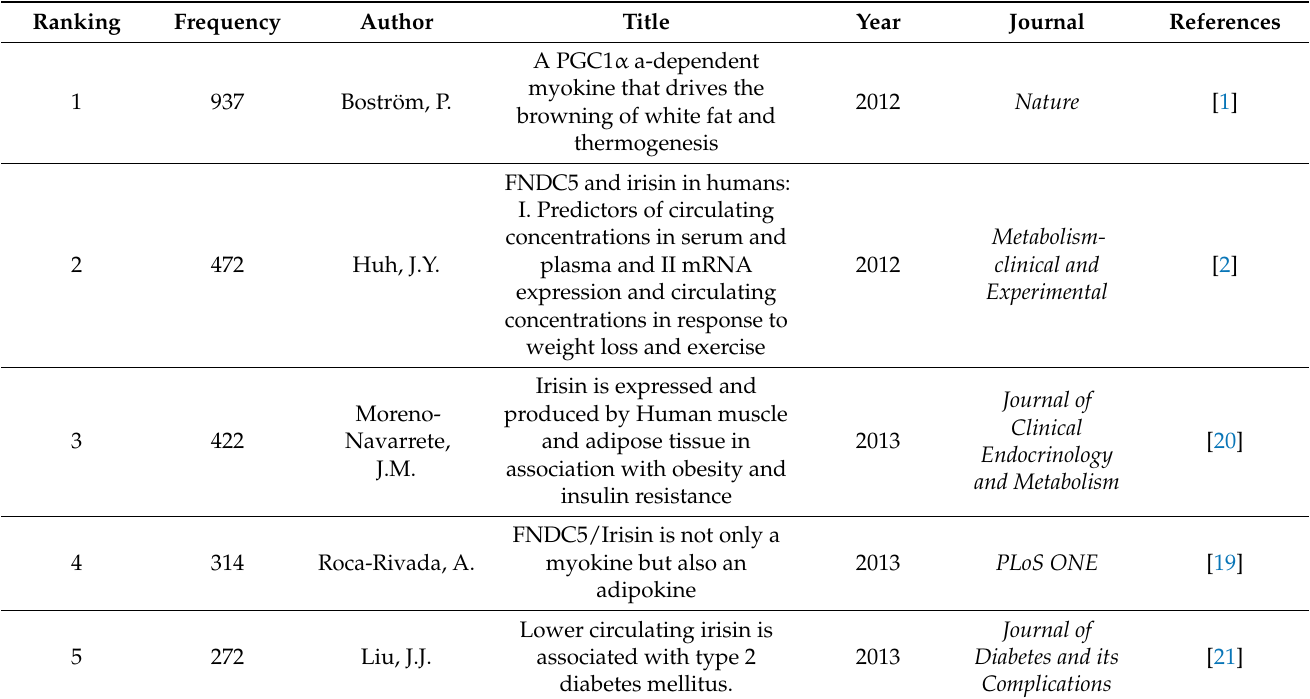
Figure 8. Timeline view of co-cited references related to irisin research. Table 5. High-frequency co-cited literature information of irisin research.